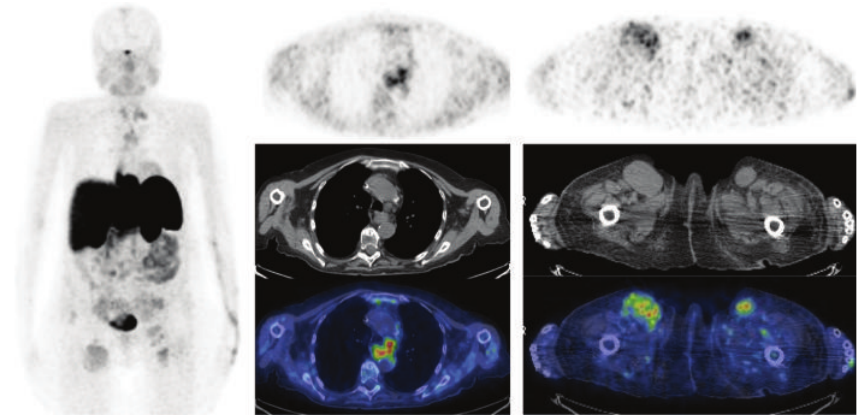
Figure 10: 68 Ga-DOTATATE PET/CT images (MIP, axial) in a patient with non-Hodgkin